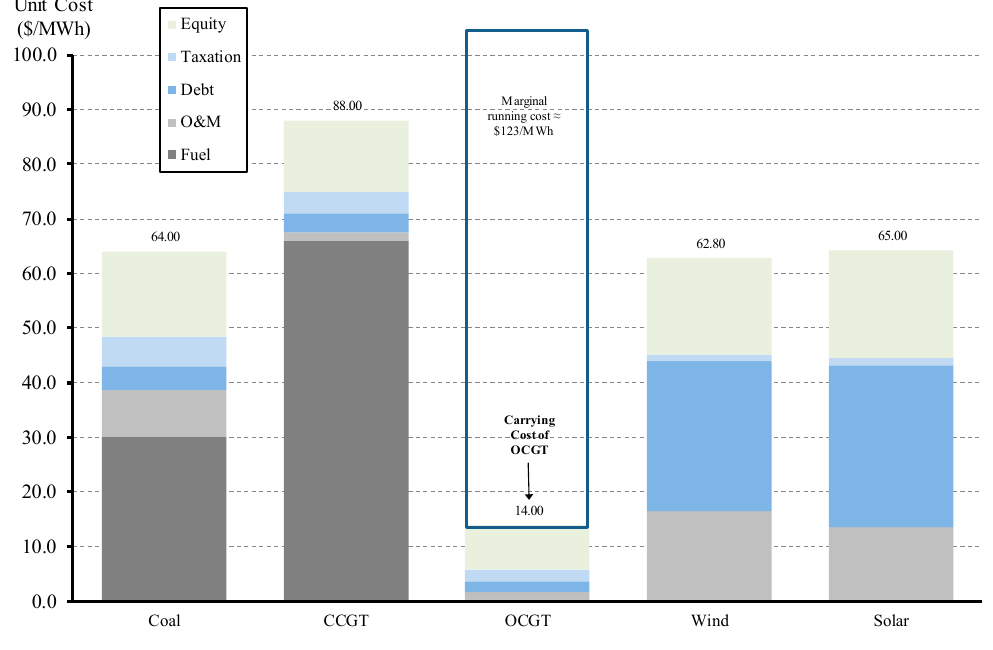
Figure 1. Generalized plant costs.